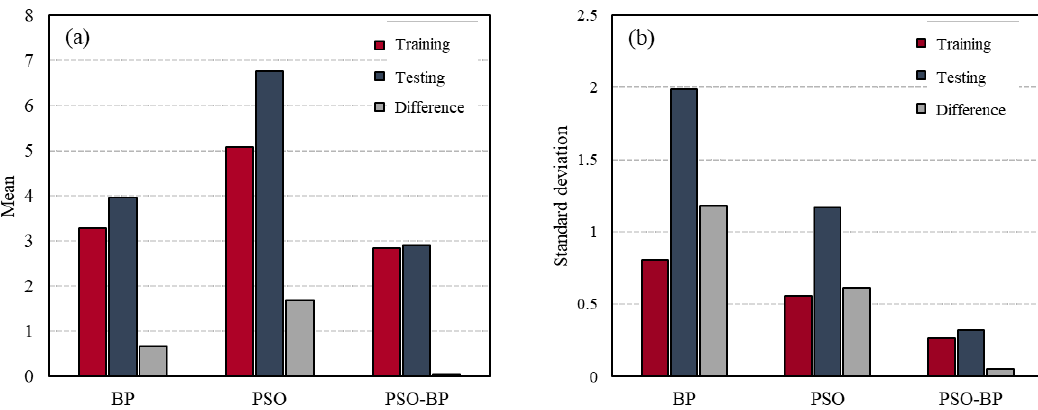
Figure 8. ( a ) Mean and ( b ) standard deviation of the root mean squared error (RMSE) for the developed models. Table 6. Mean and standard deviation of the RMSE for the developed models.